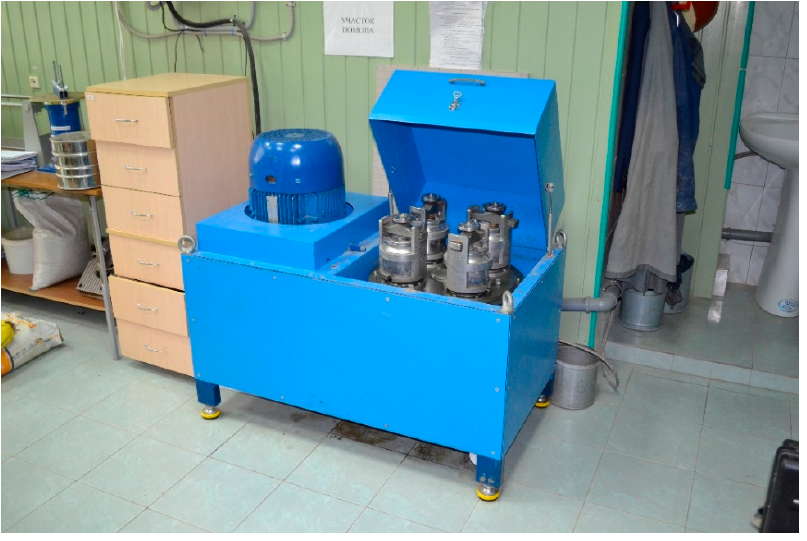
Figure 2. Planetary mill “Activator-4M”. Table 8. Technical characteristics of “Activator-4M”.